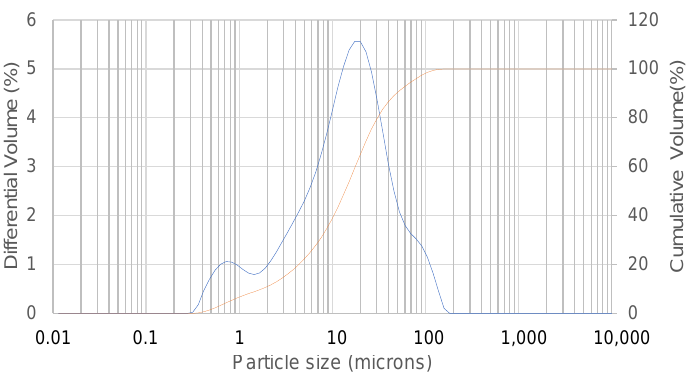
Figure 3. LASER particle size distribution of the GGBFS.